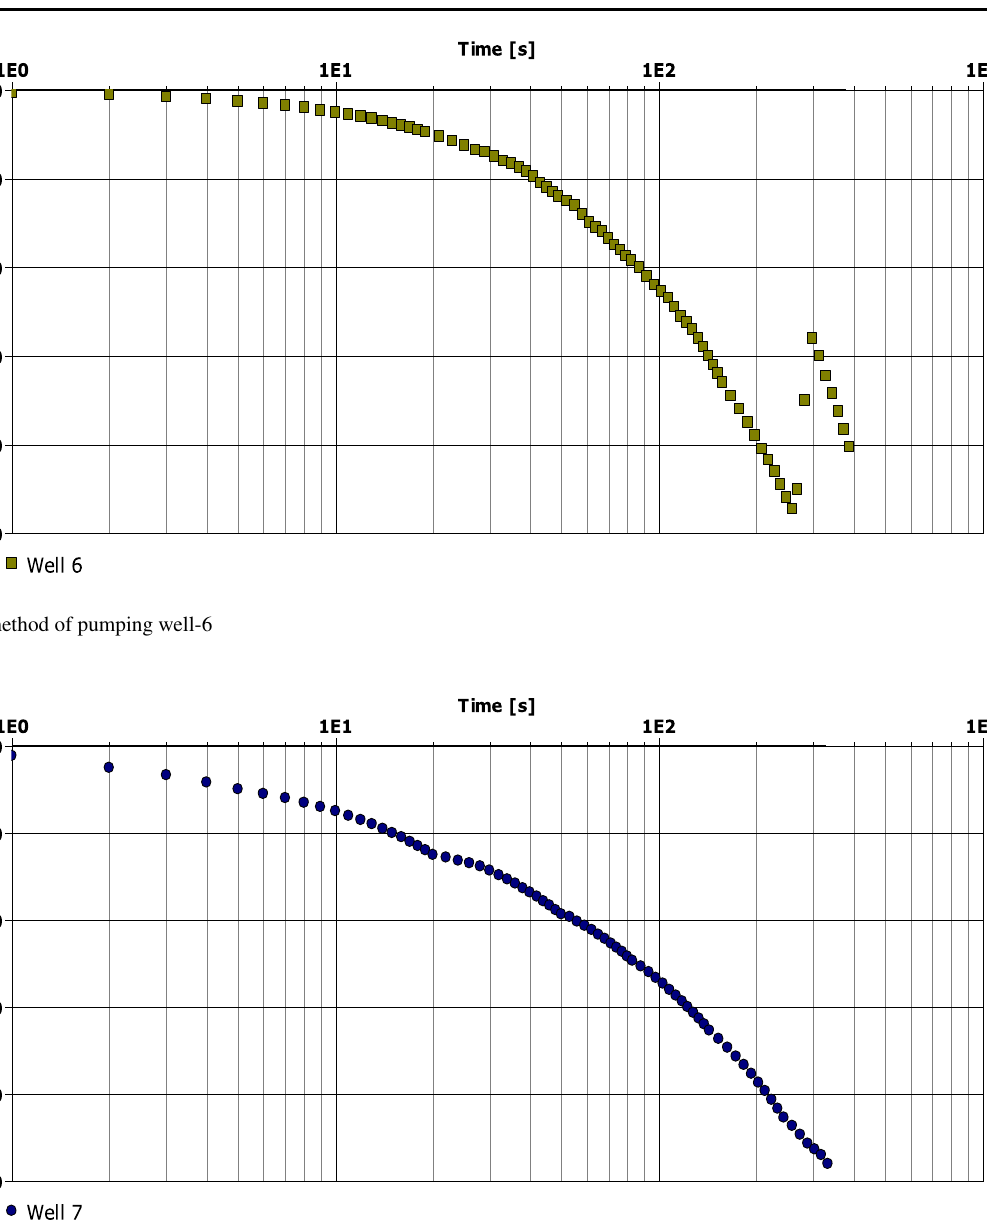
Fig. 24 Theis’s method of pumping